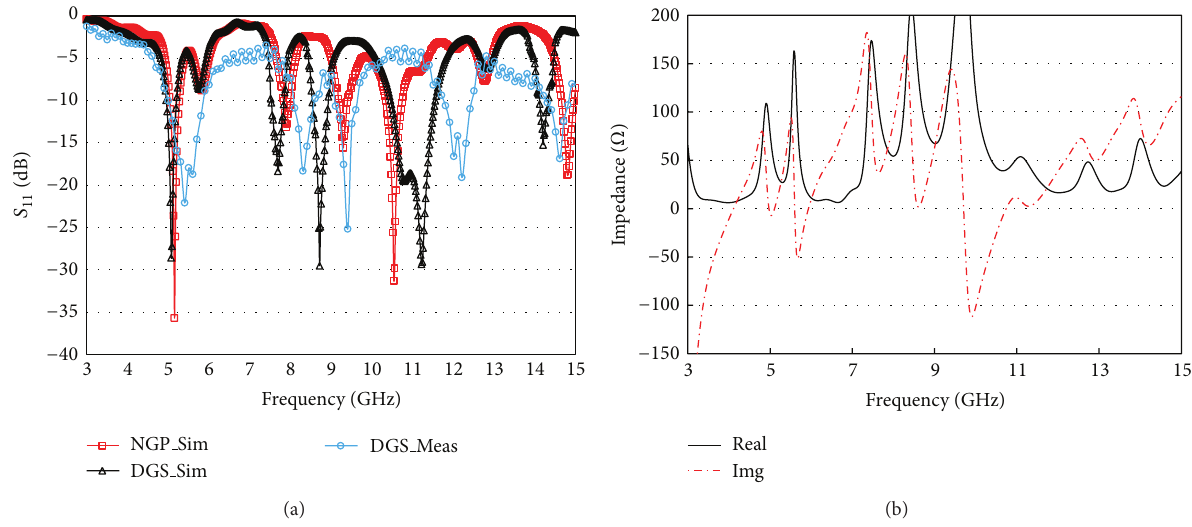
Figure 9: (a) Comparison of the simulated and measured return loss characteristics. (b) Impedance characteristics of the proposed DGS